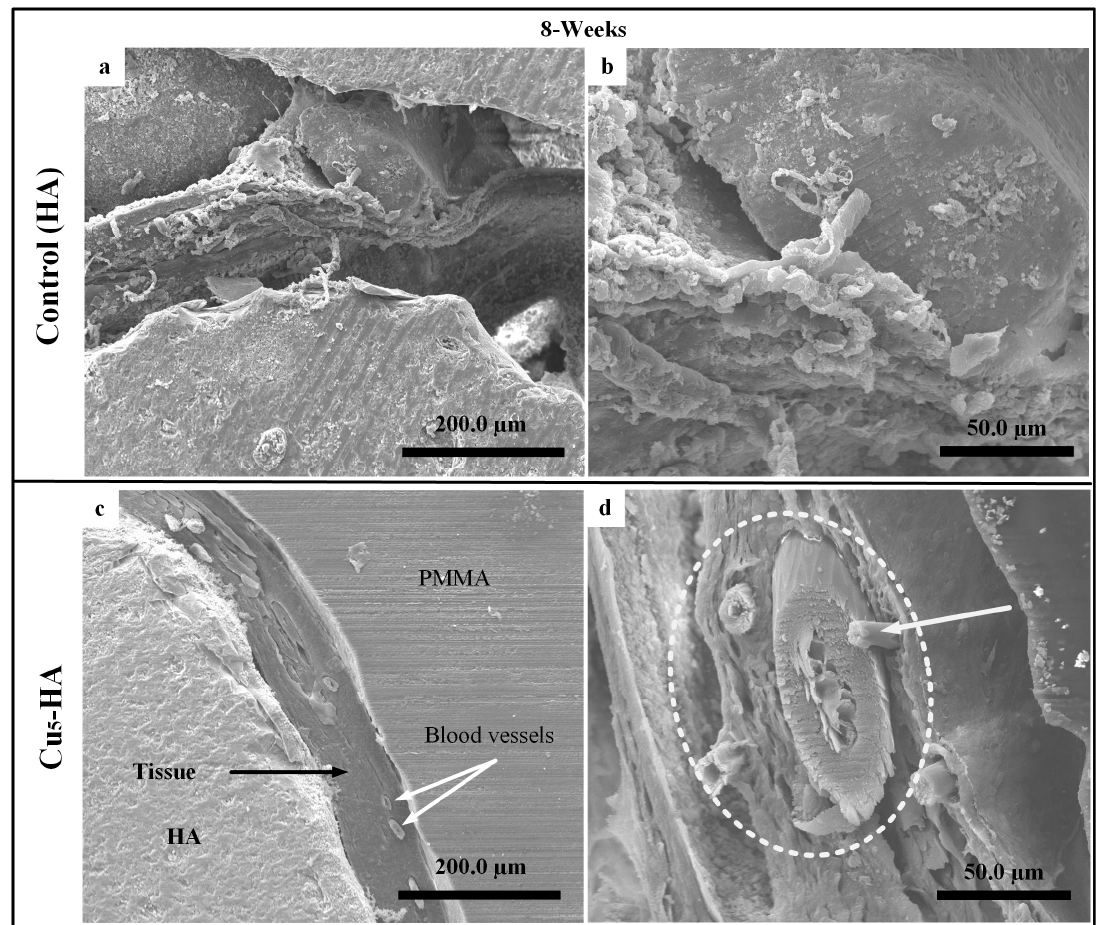
Figure 11. SEM images characterized the surface of HA, Cu 5 -HA after incubation for eight weeks on rabbits. ( a , d ) The typical morphology of HA scaffolds and ( c , d ) Cu 5 -HA scaffolds.